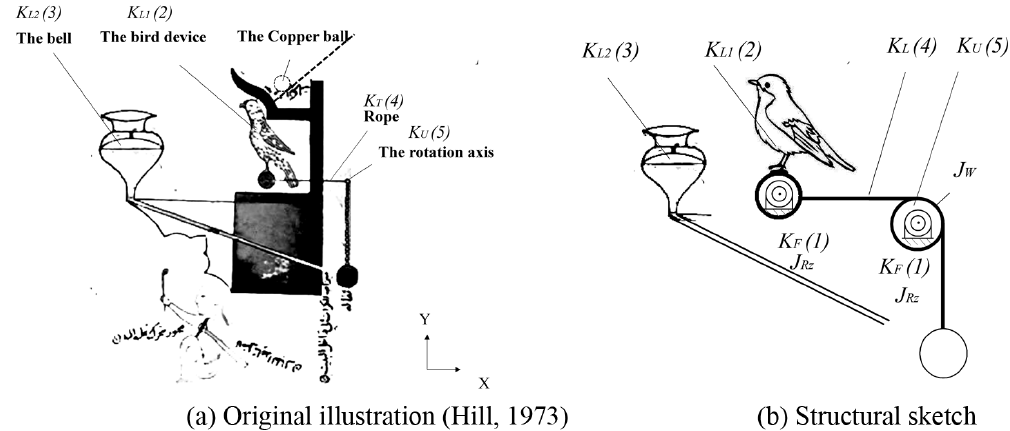
Figure 16. Al-Jazari’s falcon time-reporting